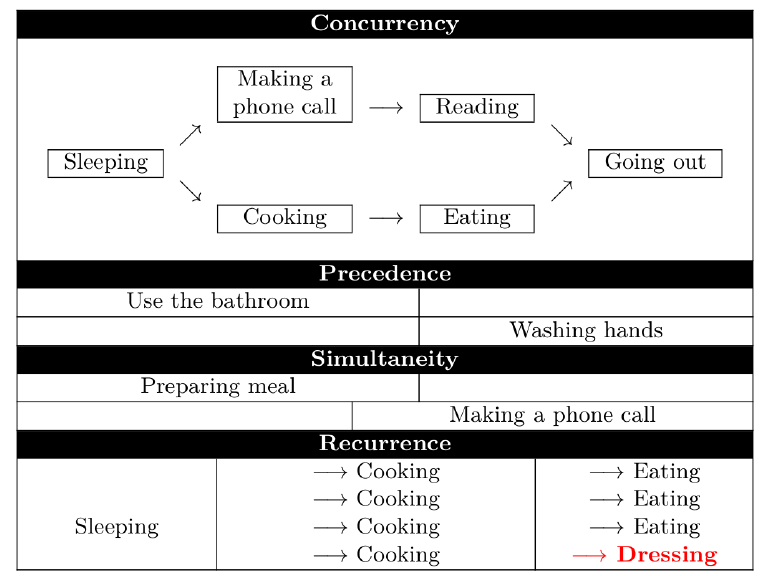
Figure 1. Criteria proposed over the time dimension.